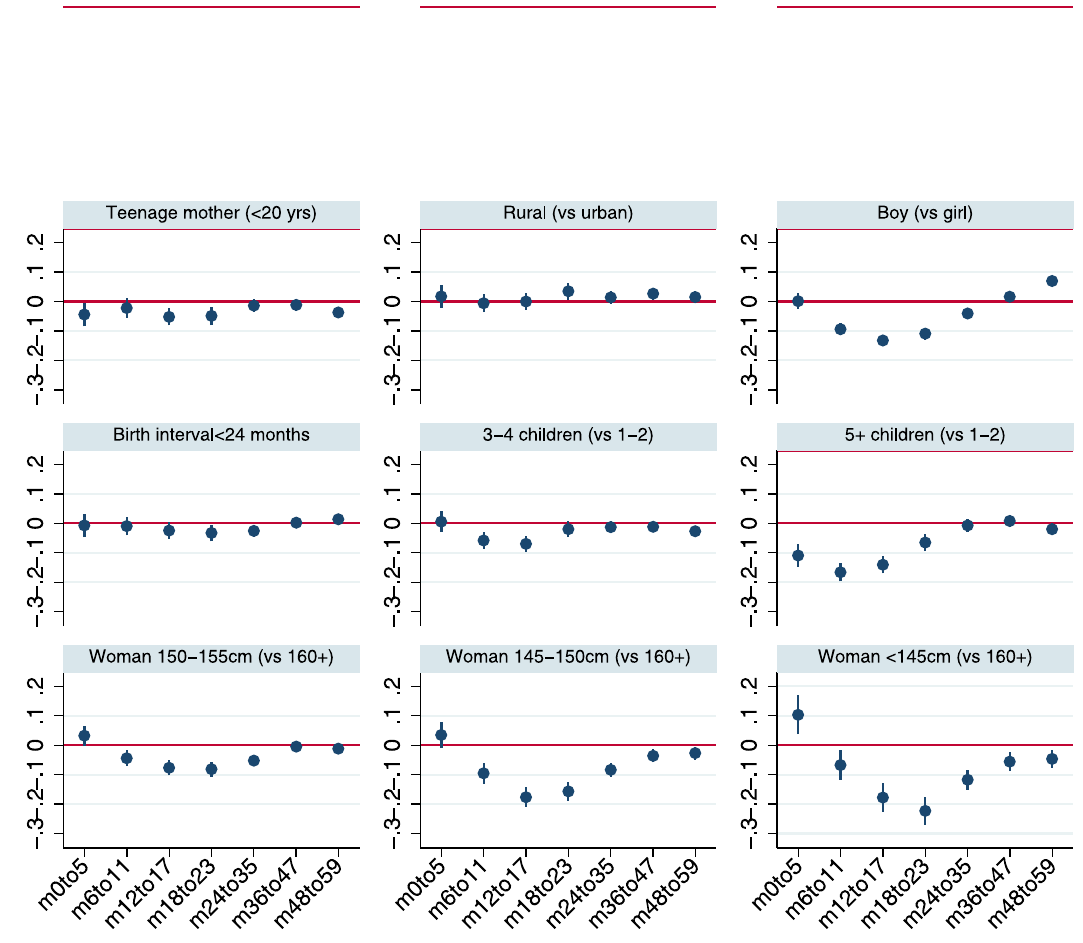
Fig 6. Least squares estimates for WHZ scores by age-restricted sub-samples: Child, maternal and household demographic indicators and maternal height. Notes: The figure reports coefficients and 95% confidence intervals based on cluster-adjusted standard errors from multivariable least squares regressions of HAZ against all the variables listed in Table 1, as well as country-year fixed effects and dummy variables for every month of child age. Samples sizes for the regressions estimated for the various age groups are 67,384 (0–5 months; m0to5 ),75,965 (6–11 months; m6to11 ),76,711 (12–17 months; m12to17 ),68,694 (18–23